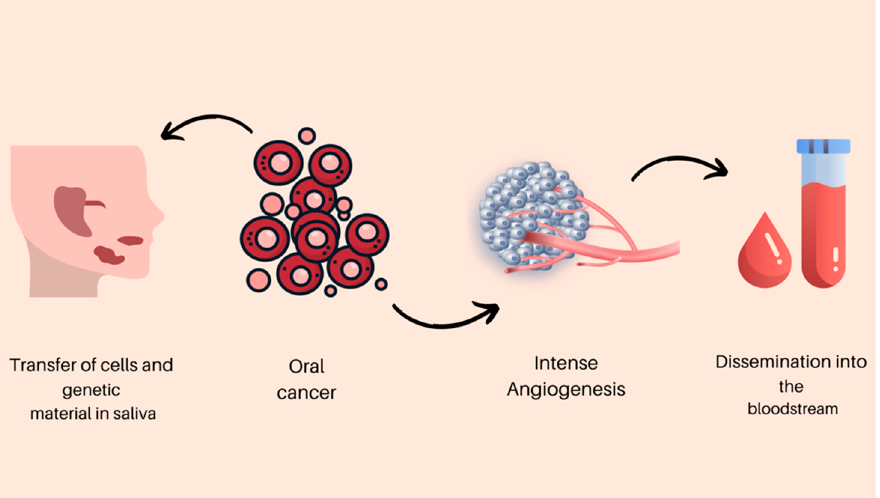
Figure 1. The carcinogenesis process and malignant cell